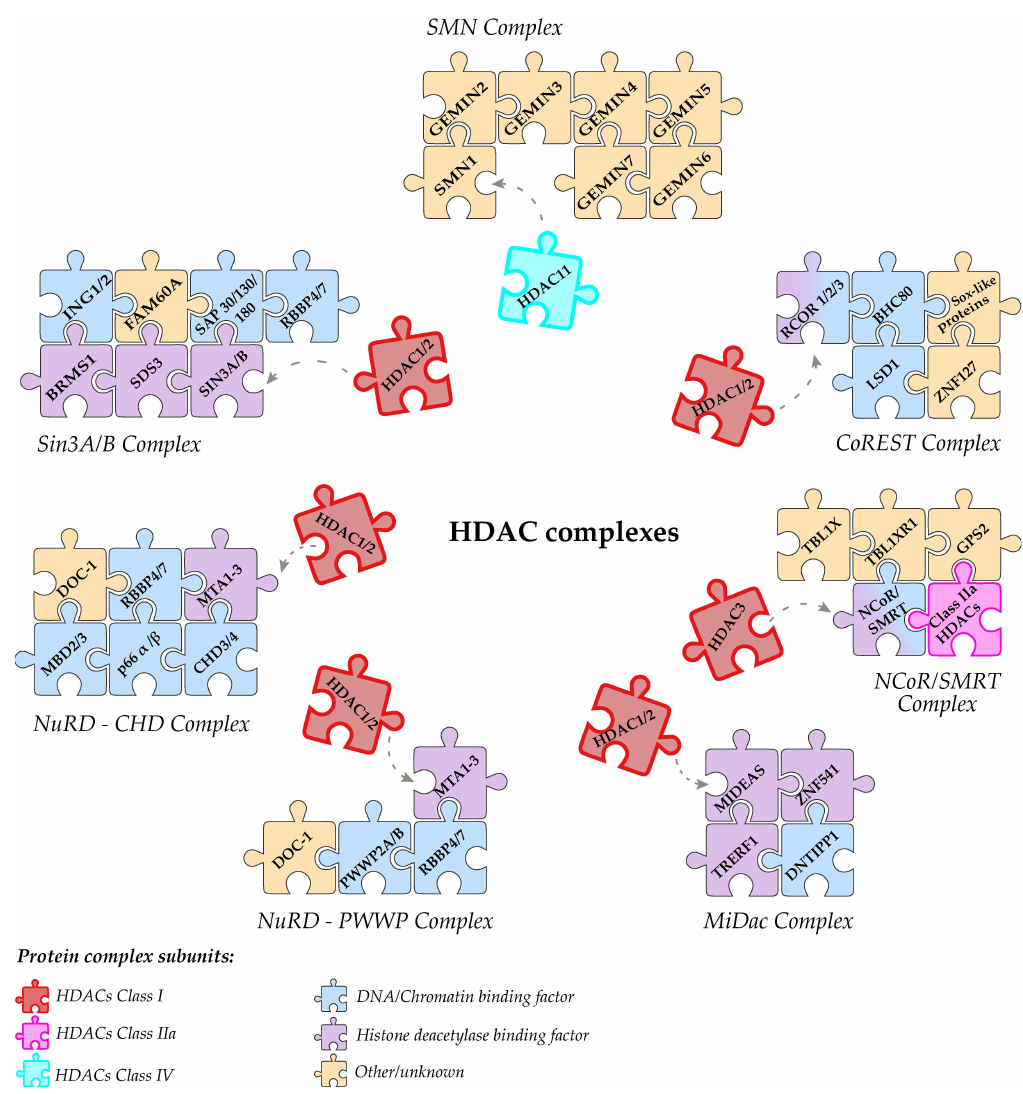
Figure 5. Schematic representation of the well characterized human HDAC-containing core complexes. Color schemes associated with HDACs subunits refer to sequence-based classification of HDACs described in this review. The recruitment of each HDAC in the core complex is depicted schematically with grey arrows that also identifying the HDAC-binding subunit. The HDAC1 / 2 / 11-binding subunit within each complex is indicated by the purple color. In addition, each complex contains multiple DNA / chromatin binding subunits indicated in blue. Finally, other subunits, where the biological function in each complex is still uncharacterized, are indicated by the sandy color. The puzzle piece representation and orientation does not reflect specific surface interaction regions. HDAC1 / 2 indicates 1 or 2, interchangeably (not as a